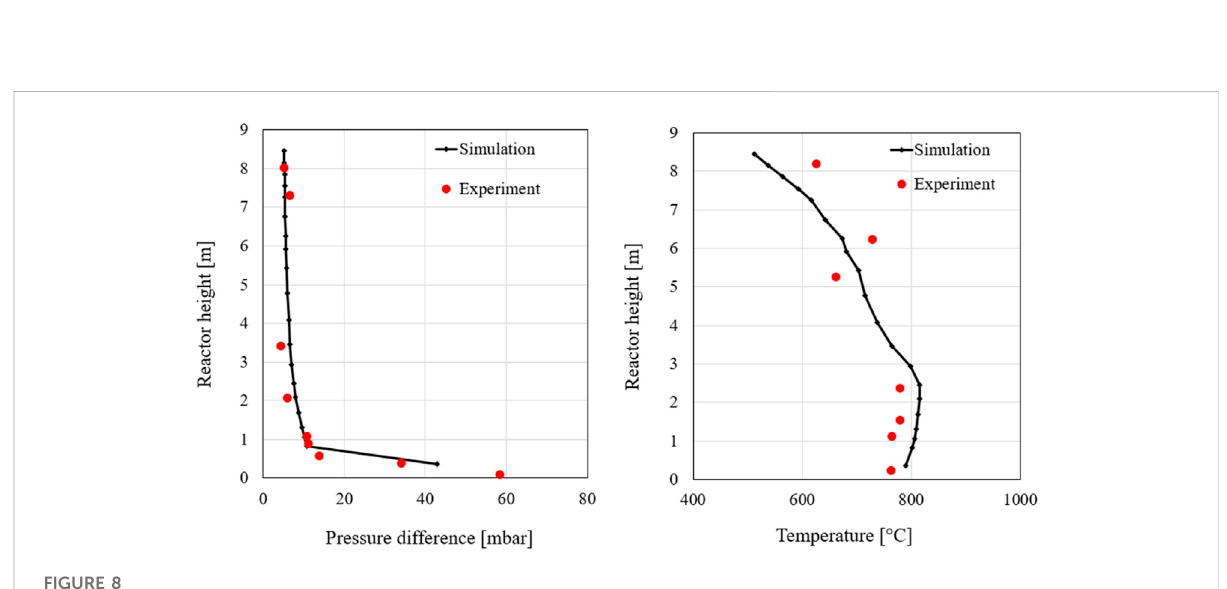
FIGURE 8 Pressure drop and temperature pro fi les along the riser at the fi rst 60% load